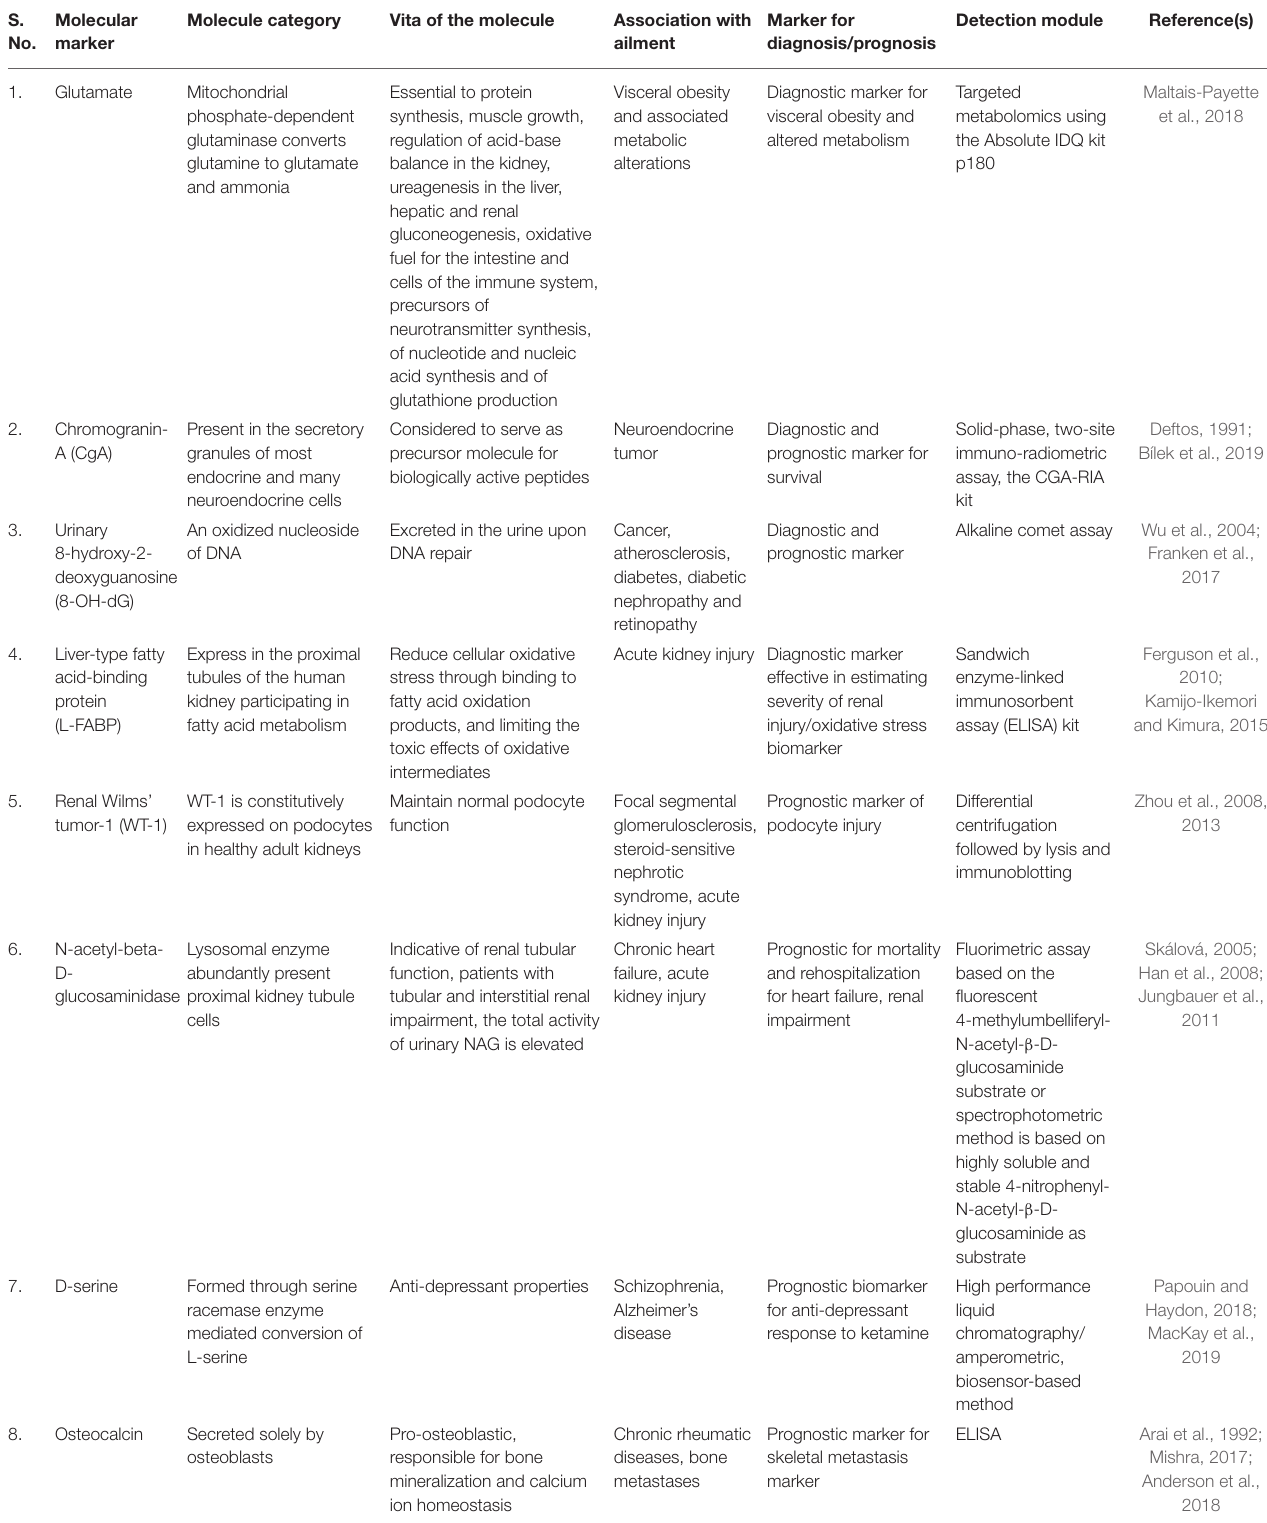
TABLE 3 | Overview of various biomolecules having diagnostic/prognostic values along with their association with various ailments. S. Molecular No.